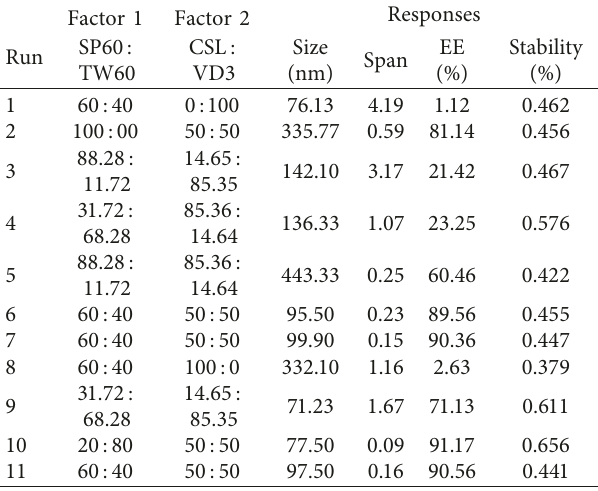
Table 1: Variables and levels and responses used in